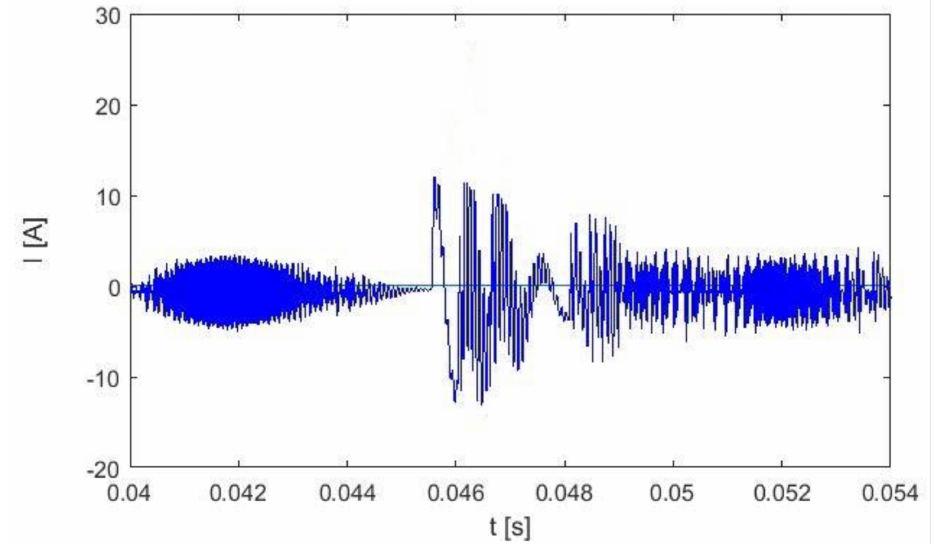
Figure 12. Current waveform between the H-bridge and Graetz bridge.